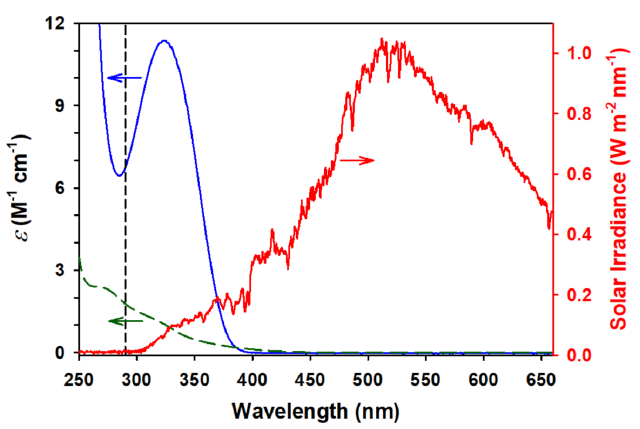
Figure 3. The molar absorption coefficients ( ε , left axis ) in the UV-visible absorption spectra of ( dashed green ) glyoxylic acid and ( solid blue ) pyruvic acid in water, and ( red and right axis ) direct solar irradiance spectrum from a sunny and cloudless day (19 August 2018) in Lexington, KY (USA) at 230 m above ground level. The vertical dashed line indicates the ozone cut-off at a wavelength ≥ 290 λ cut-off